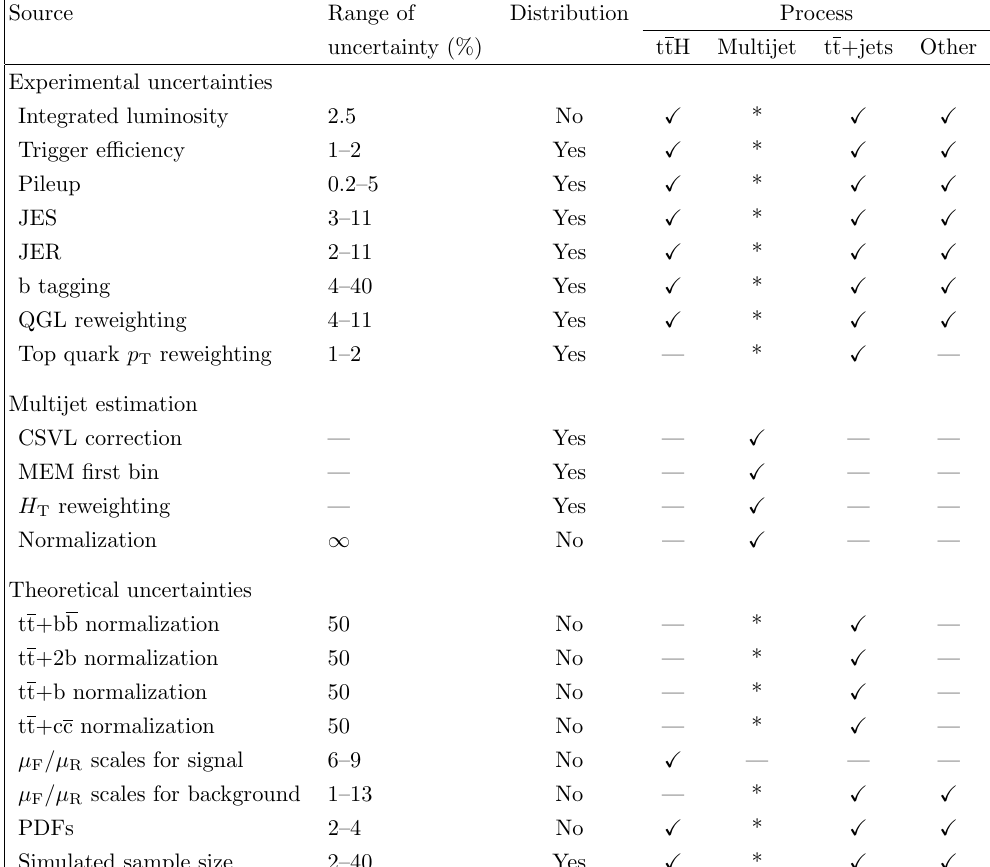
Table 5 . Summary of the systematic uncertainties a(cid:11)ecting the signal and background expecta- tions. The second column indicates the range in yield of the a(cid:11)ected processes, caused by changing the nuisance parameters by their uncertainties. The third column indicates whether the uncer- tainties impact the distribution in the MEM discriminant. A check mark ( X ) indicates that the uncertainty applies to the stated processes. An asterisk (*) indicates that the uncertainty a(cid:11)ects the multijet distribution indirectly, because of the subtraction of directly a(cid:11)ected backgrounds in the CR in